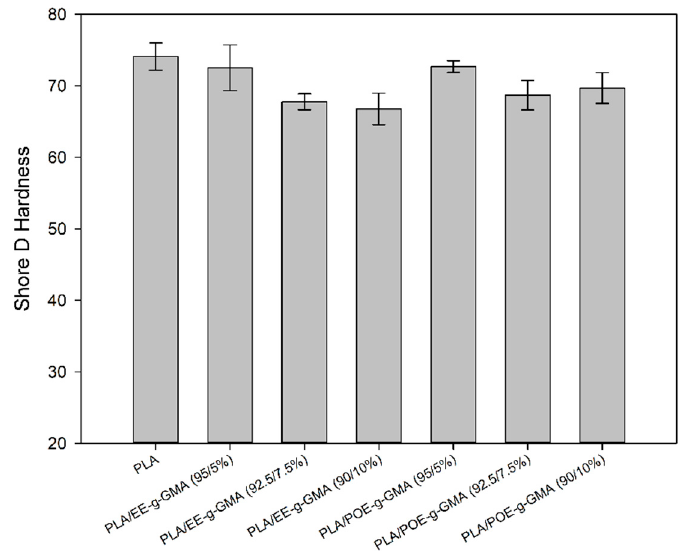
Figure 7. Shore D hardness of pure PLA and the blends containing 5; 7.5 and 10% EE-g-GMA and POE-g-GMA.